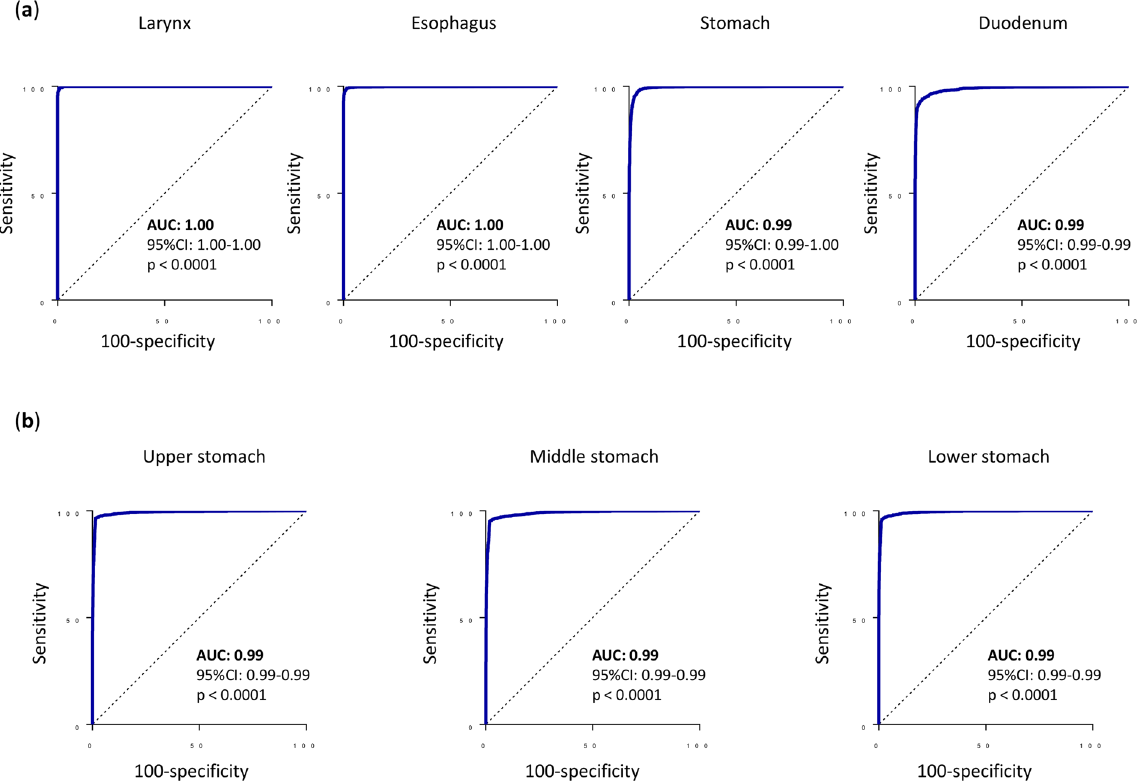
Figure 1. ( a ) The convolutional neural network (CNN) recognized the anatomical location of gastro-intestinal endoscopy images very accurately with area under the curve (AUC) values of 1.00 [95% confidence interval (CI): 1.00-1.00, p < 0.0001] for the larynx, 1.00 (95%CI: 1.00–1.00, p < 0.0001) for the esophagus, 0.99 (95%CI: 0.99–1.00, p < 0.0001) for the stomach, and 0.99 (95%CI: 0.99–0.99, p < 0.0001). ( b ) The convolutional neural network (CNN) recognized the anatomical location of the stomach images accurately with AUC values of 0.99 (95%CI: 0.99–0.99, p < 0.0001) for the upper stomach, 0.99 (95%CI: 0.99–0.99, p < 0.0001) for the middle stomach, and 0.99 (95%CI: 0.99-0.99, p < 0.0001) for the lower stomach.